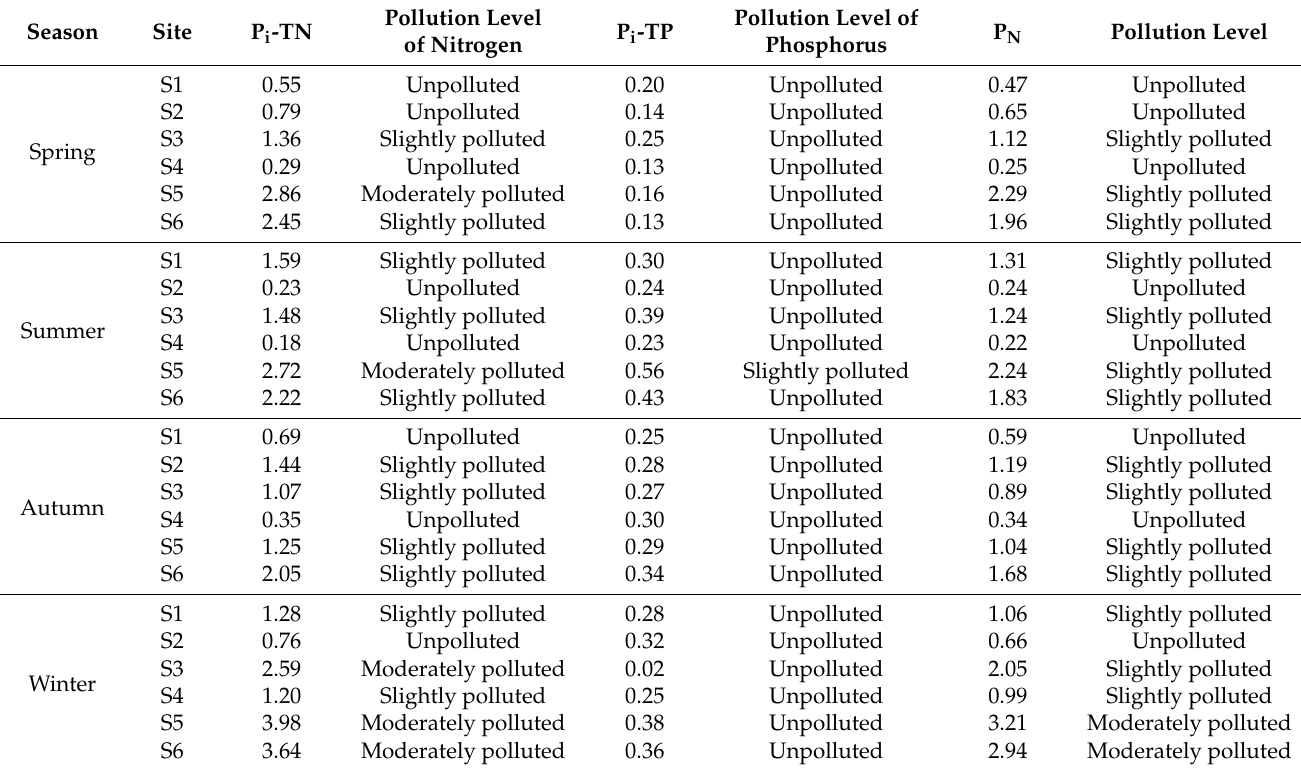
Table 1. Pollution index values of total nitrogen (P i -TN), total phosphorus (P i -TP), and Nemerow pollution index values of nutrients (P N ) in the sediments of the QCS